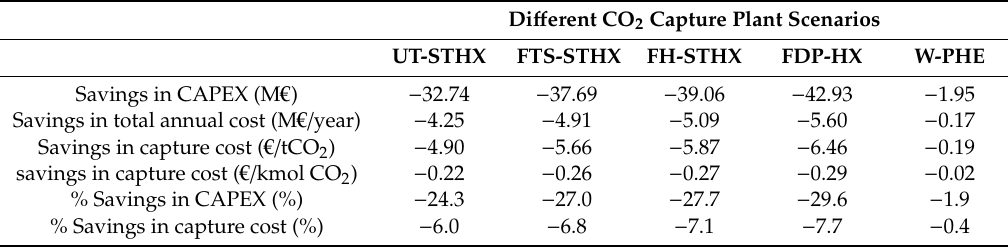
Table 7. Comparison of cost performance of the G-PHE capture plant scenario with other plant